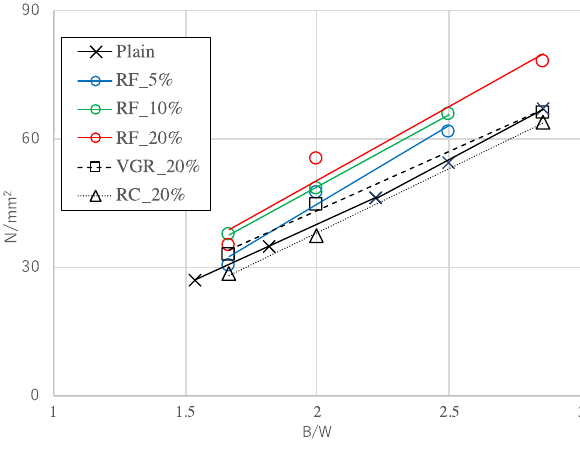
Fig. 22 B/W-compressive strength relation